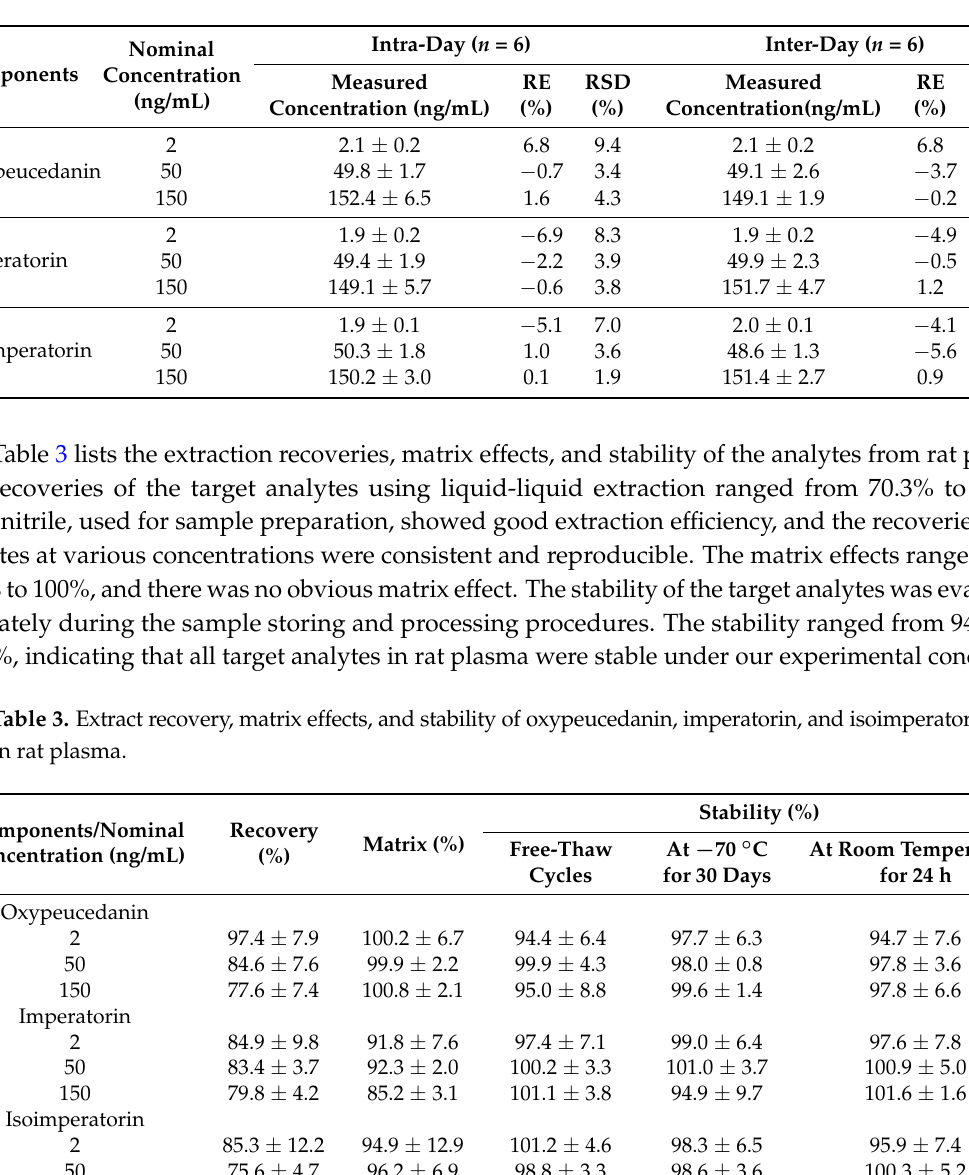
Table 2. Accuracy and precision of oxypeucedanin, imperatorin, and isoimperatorin in rat plasma.